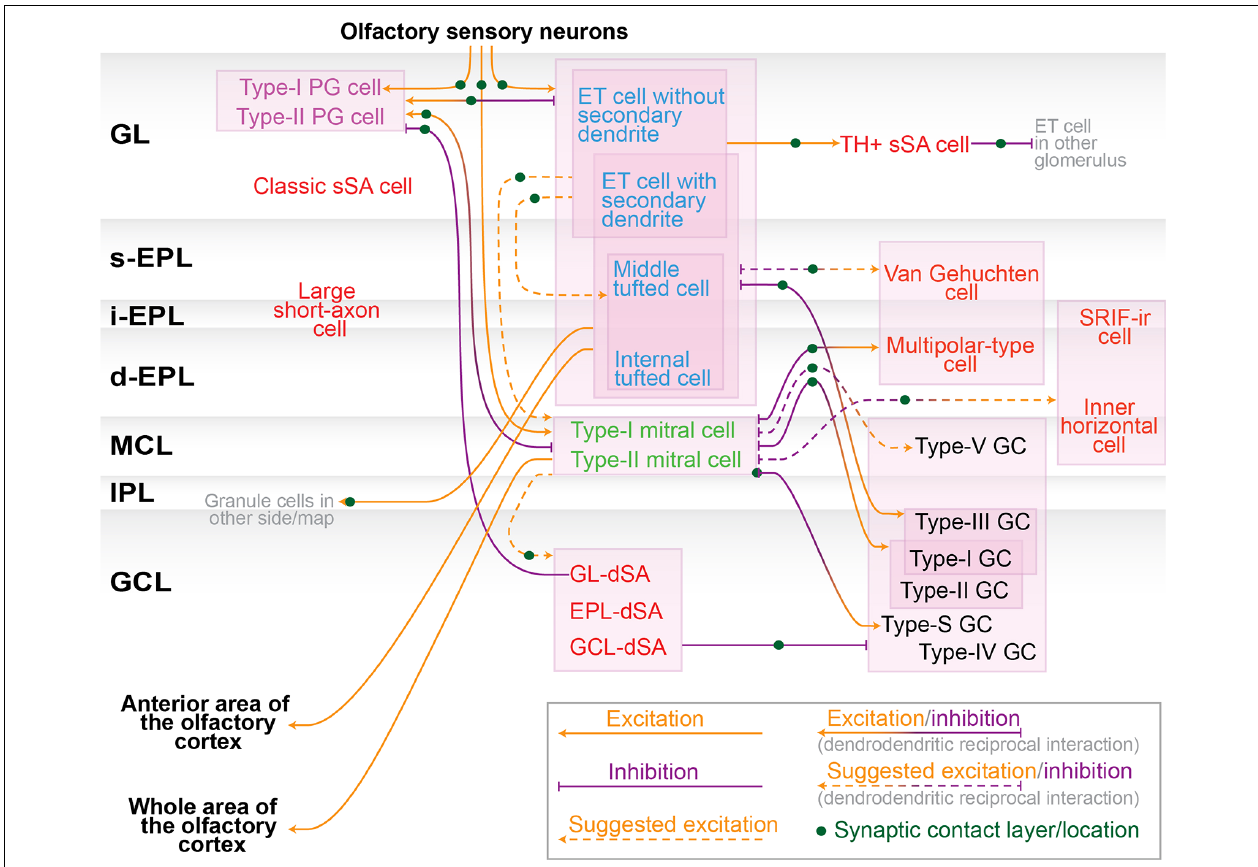
unwired due to lack of sufficient information. Note that there are interactions not appeared in this diagram, including electric couplings between divergent neurons (e.g., mitral–mitral, mitral–tufted, tufted–tufted and mitral–interneurons; Kosaka and Kosaka, 2003; Christie etal., 2005;